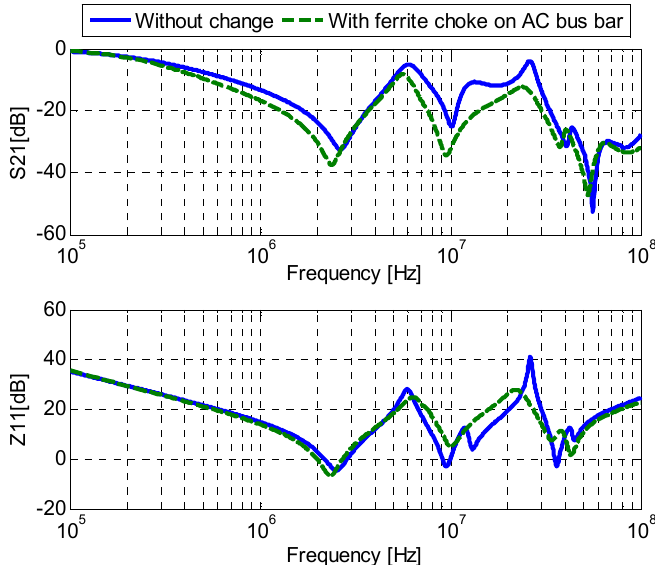
Figure 17. Change in Z11 and S21 after adding a CM ferrite choke on the AC bus bar.